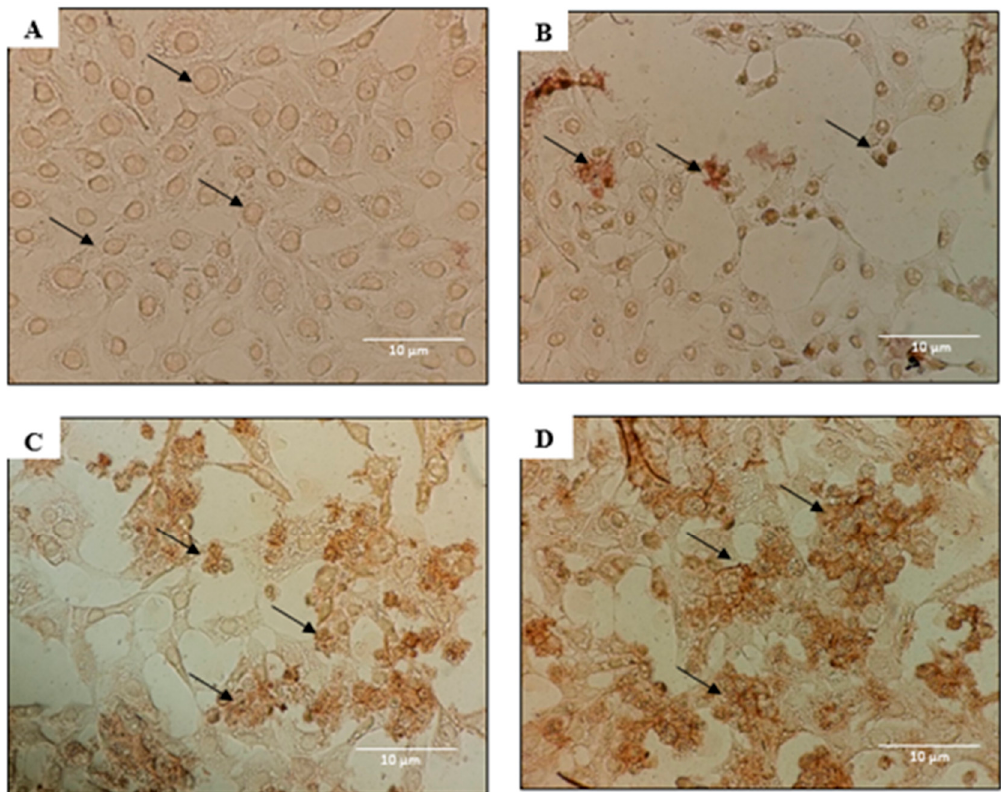
Figure 2. Raphasatin-mediated apoptosis in MCF-7 cells, as determined using the DeadEnd Colorimetric terminal deoxynucleotidyl transferase dUTP nick end labelling (TUNEL) assay. MCF-7 cells were treated with 9.84 µM (IC 50 ) concentration of raphasatin for various periods of time. Images represent one of three independent experiments. Morphological changes after the treatment for 24 h ( B ), 48 h ( C ), and 72 h ( D ) were compared with the untreated cells ( A ), which acted as control. The arrows in A denote the viable unaffected cells, and in B , C , and D are the typical apoptotic cells (dark brown color stained in B , C , and D ) resulting from nuclear DNA fragmentation.